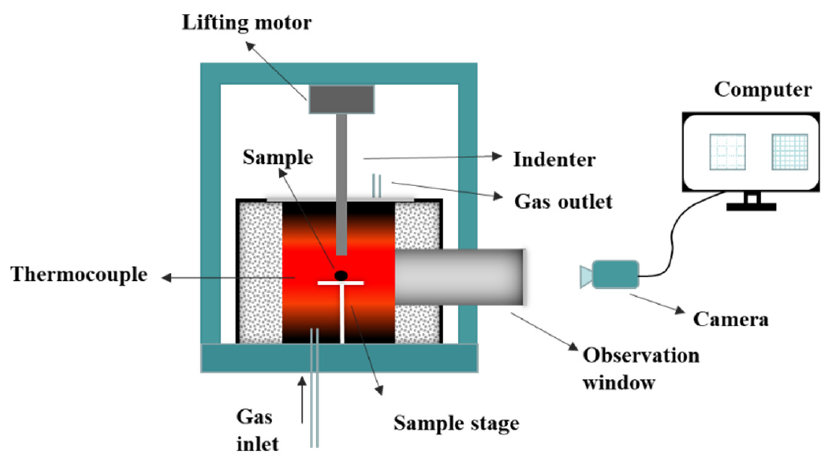
Figure 4. Testing equipment of hot compression strength of sample during gasification.